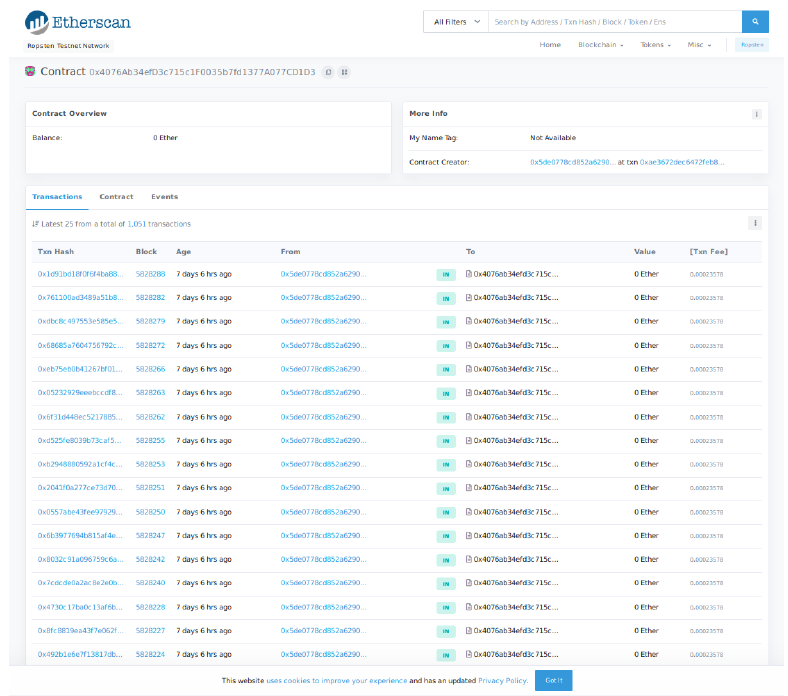
Figure 17. Ropsten testnet main view of the transactions related to the deployed smart